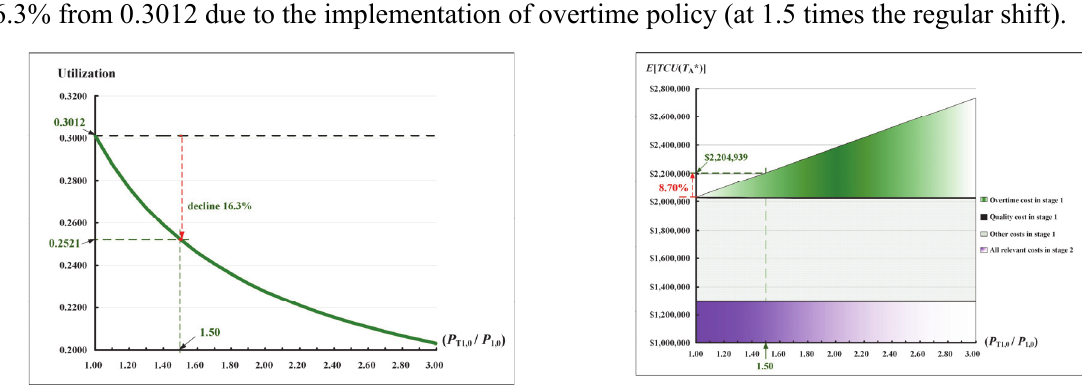
Fig. 7. The influence of overtime factor on overall Fig. 8. The effect of overtime factor on different